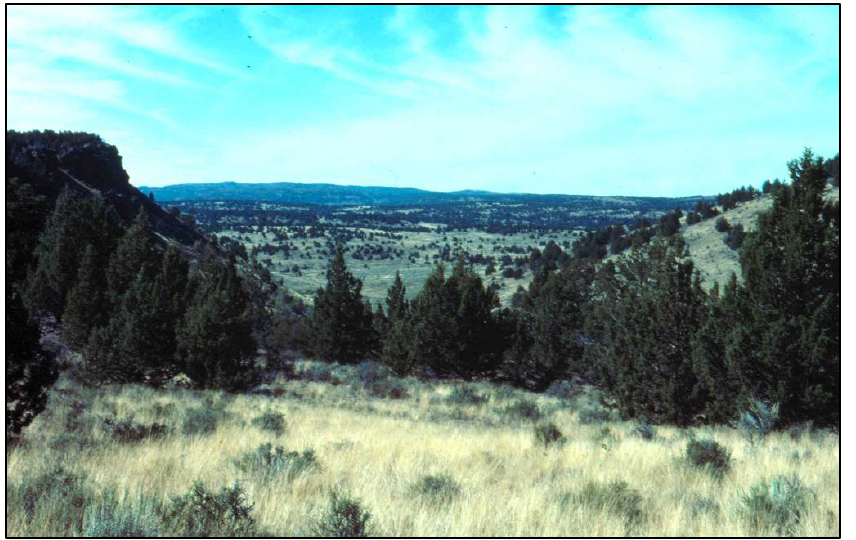
Figure 1. Overview of sagebrush steppe and western juniper woodland landscape in the Owyhee Mountains of southwestern Idaho.